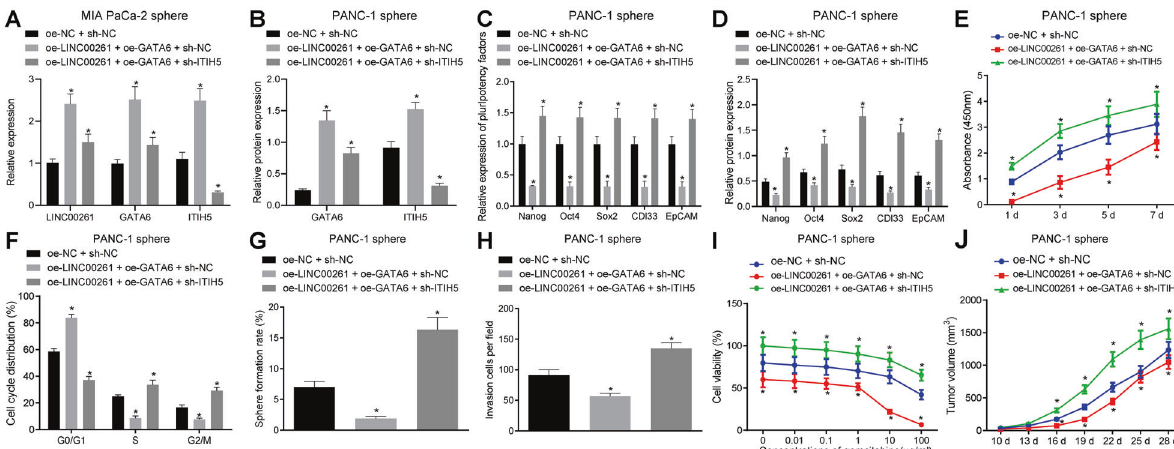
Fig. 7 Overexpression of LINC00261 reduces tumorigenicity PC stem cells by increasing ITIH5 via binding to GATA6. A Transfection ef fi ciency of ITIH5 silencing in PANC-1 stem cells determined by RT-qPCR. B The transfection ef fi ciency of ITIH5 silencing, LINC00261, and GATA6 overexpressing in PANC-1 stem cells measured by western blot analysis. C The expression of stem cell markers in PANC-1 stem cells after ITIH5 silencing in the presence of LINC00261 and GATA6 detected by RT-qPCR. D The protein expression of stem cell markers in PANC-1 stem cells after ITIH5 silencing in the presence of LINC00261 and GATA6 measured by western blot assay. E Proliferation of PANC-1 stem cells after ITIH5 silencing in the presence of LINC00261 and GATA6 examined by CCK-8 assay. F Cell cycle distribution of PANC-1 stem cells after ITIH5 silencing in the presence of LINC00261 and GATA6 examined by fl ow cytometry. G Cell sphere formation ability of PANC-1 stem cells. H Invasion of PANC-1 stem cells assessed by Transwell assay. I Cytotoxicity of PANC-1 cells. J Tumor volume in nude mice bearing PANC-1 stem